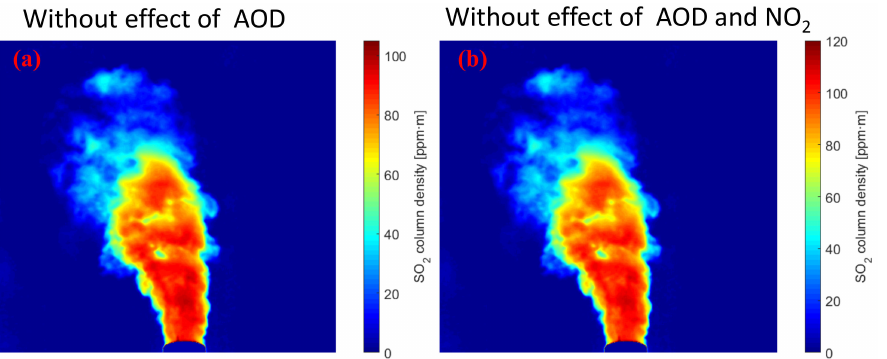
Figure 8. SO 2 CD of industrial emission obtained by UV camera in the presence of aerosols within the plume. ( a ) with aerosol scattering considered; ( b ) with the NO 2 absorption and aerosol scatter- ing